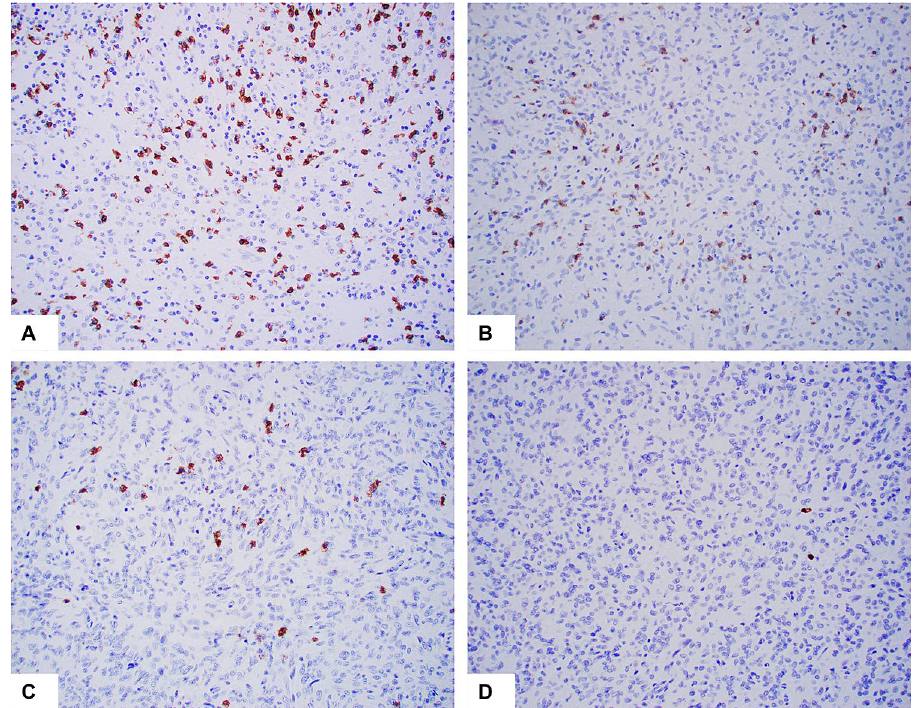
positive cells) to 0 ( D , two rare positive cells). ( B , C ) 2 + and 1 + staining, respectively. Original magnification: ×200 for